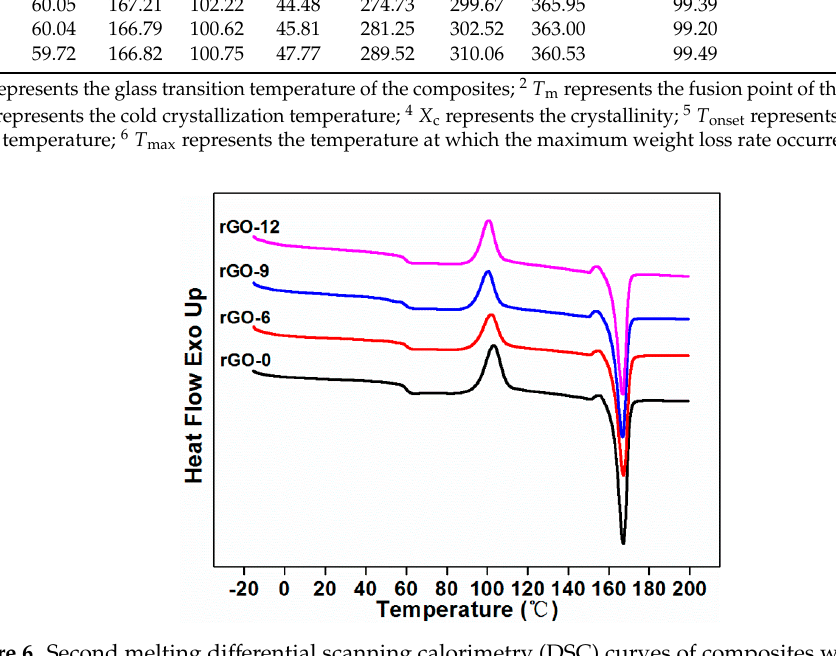
Table 3. Characteristic values of the di ff erential scanning calorimetry (DSC) and thermogravimetric analysis (TGA) curves of the composites at di ff erent rGO loading.